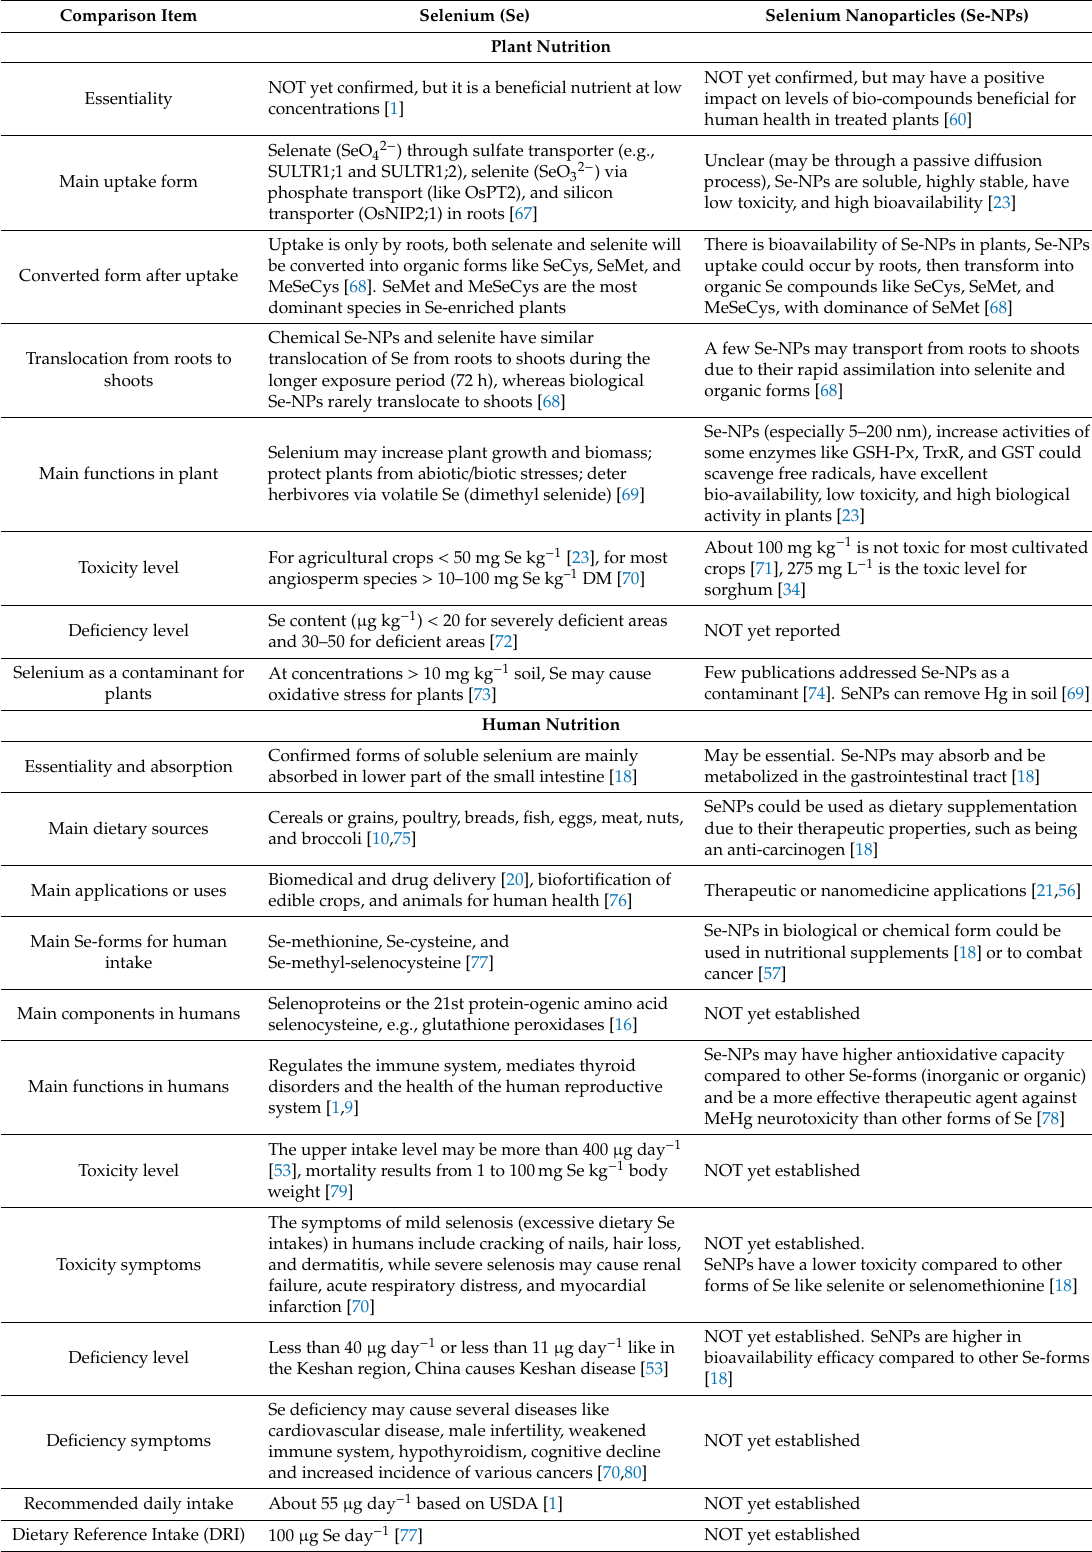
Table 1. The biological features of selenium and nano-selenium and the possible roles in plant and human